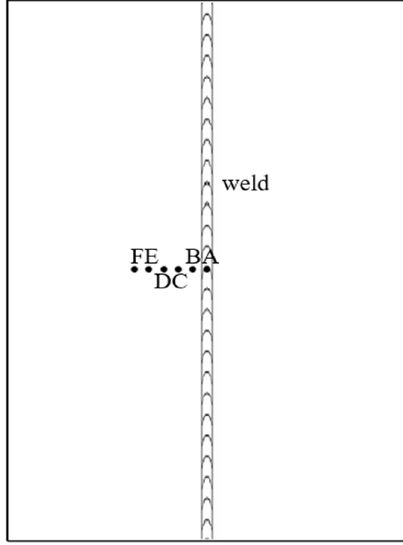
Figure 9. Front view of test panel.